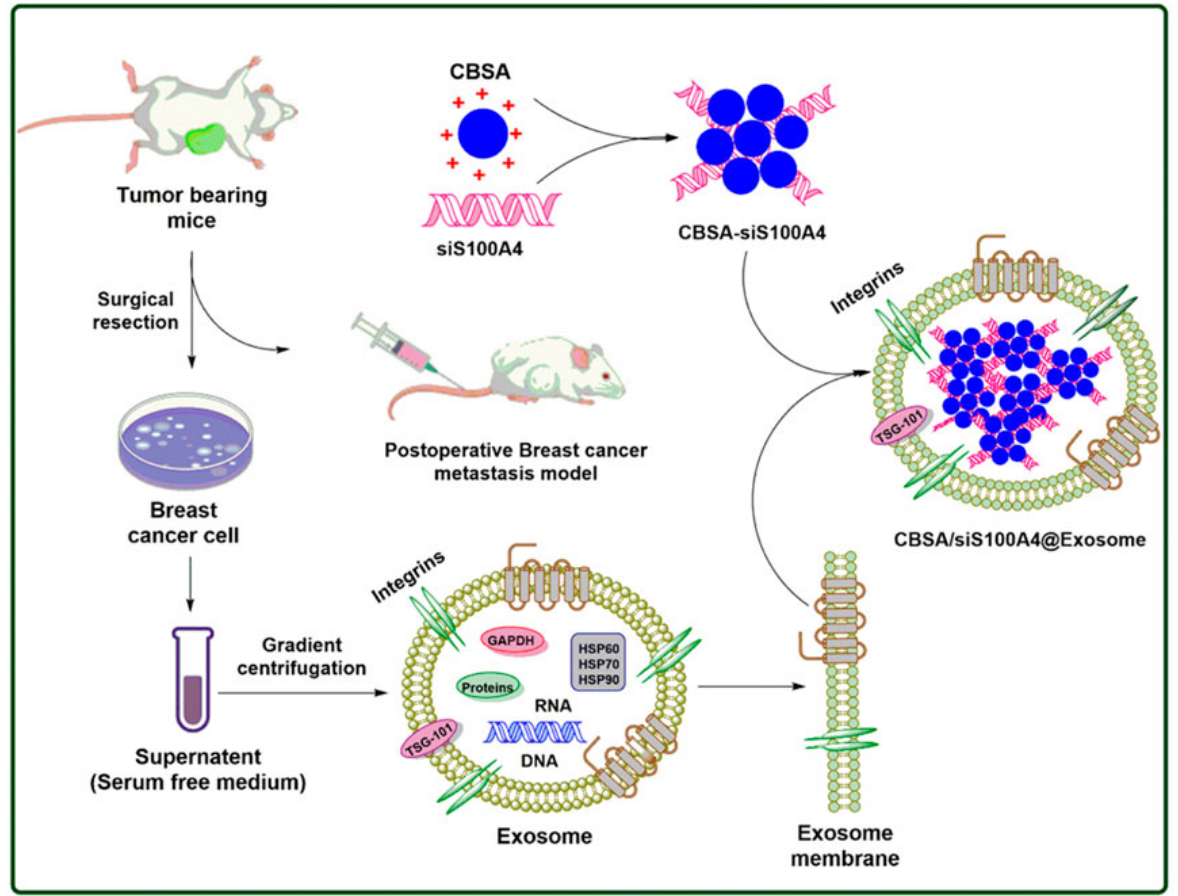
Figure 4. Post-operation metastatic inhibition in breast tumors through CBSA/siS100A4@Exosome. Adapted with permission from Ref. [99]. Copyright @2022, Goyal, Chopra, singh, Dua and Gautam.